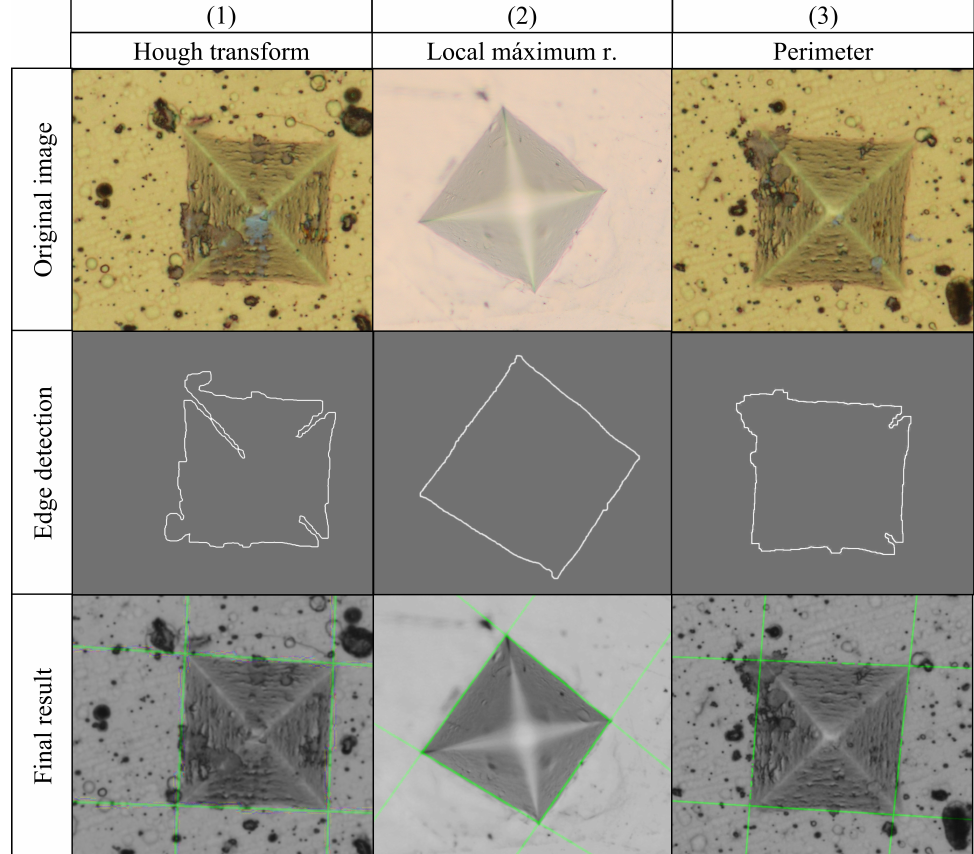
Figure 11. Example of proposed solutions. Column 1. Sample TiNbN-2; Column 2. Sample Steel-3; and Column 3. Sample TiNbN-3 with applied force of